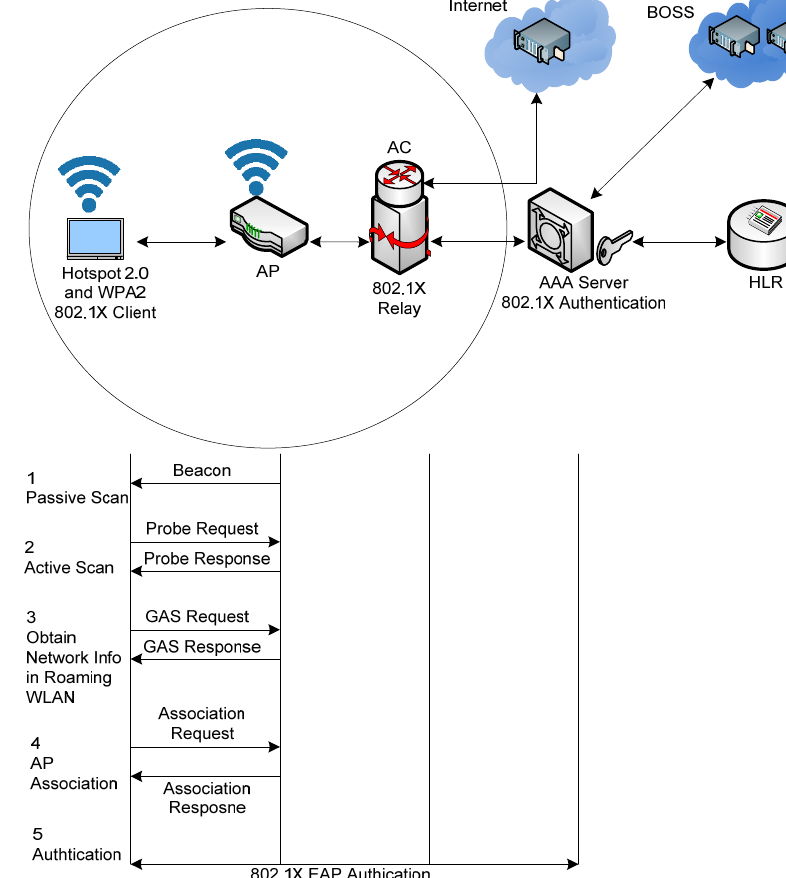
Figure 2. Generic structure of Hotspot 2.0.